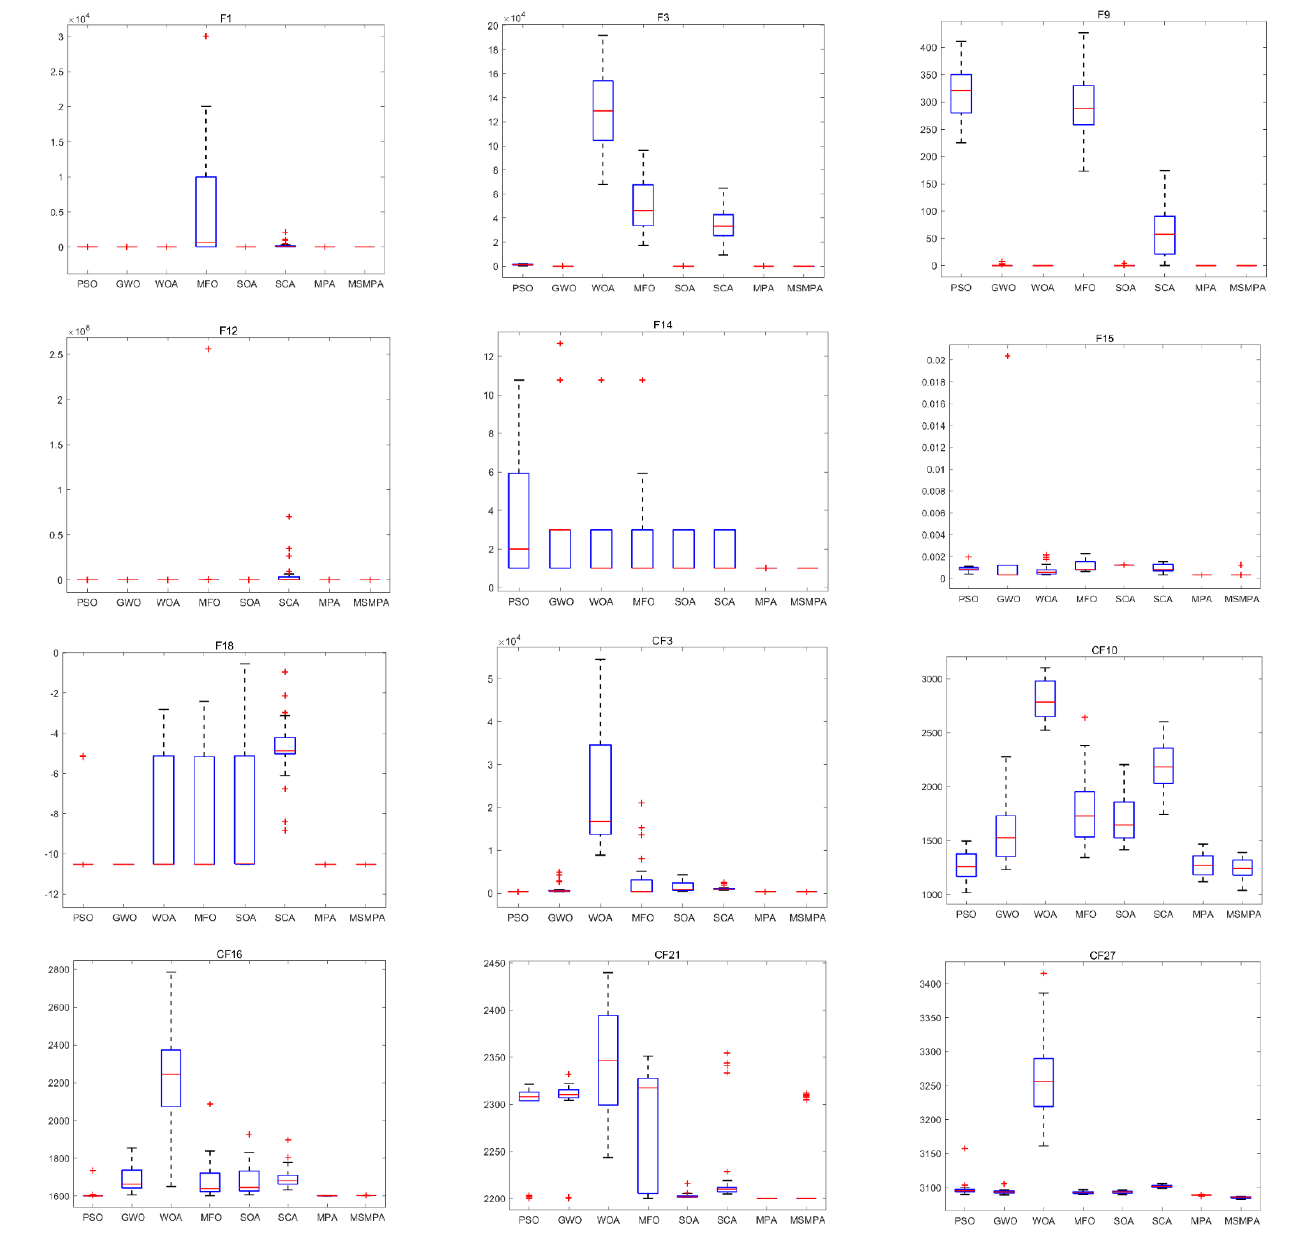
Figure A1. Convergence curves for 18 benchmark functions.